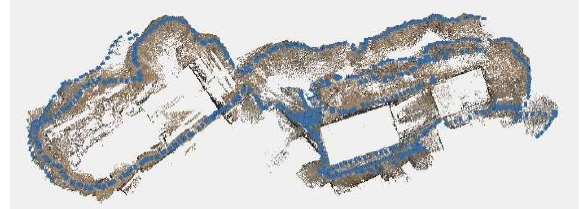
Figure 2. Small portions, correctly oriented, of the acquisition carried out thanks to the pole.